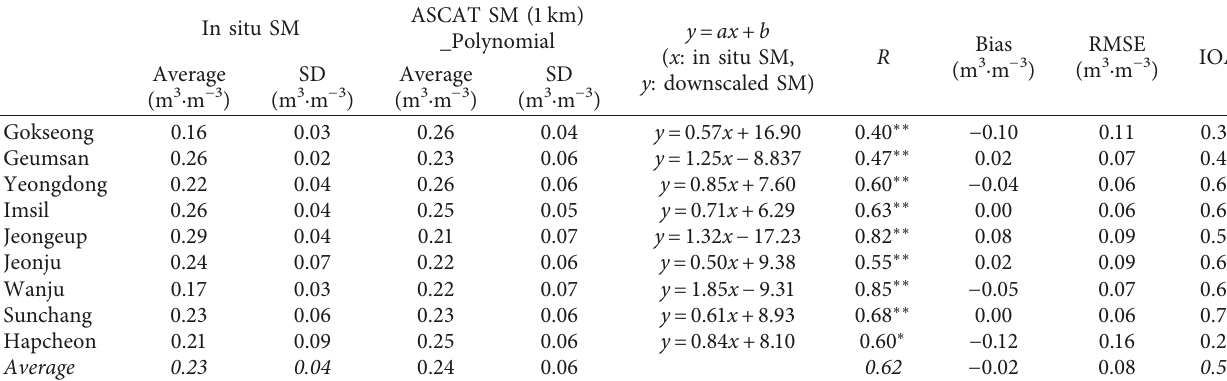
Table 6: Comparison between in situ and downscaled (1km) ASCAT SM_Polynomial.